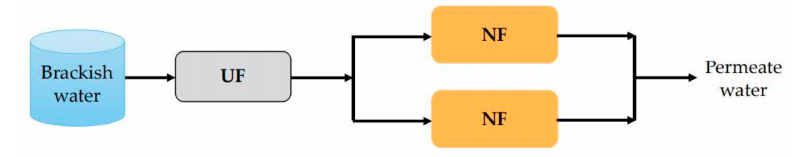
Figure 7. Schematic diagram of the UF–NF system.